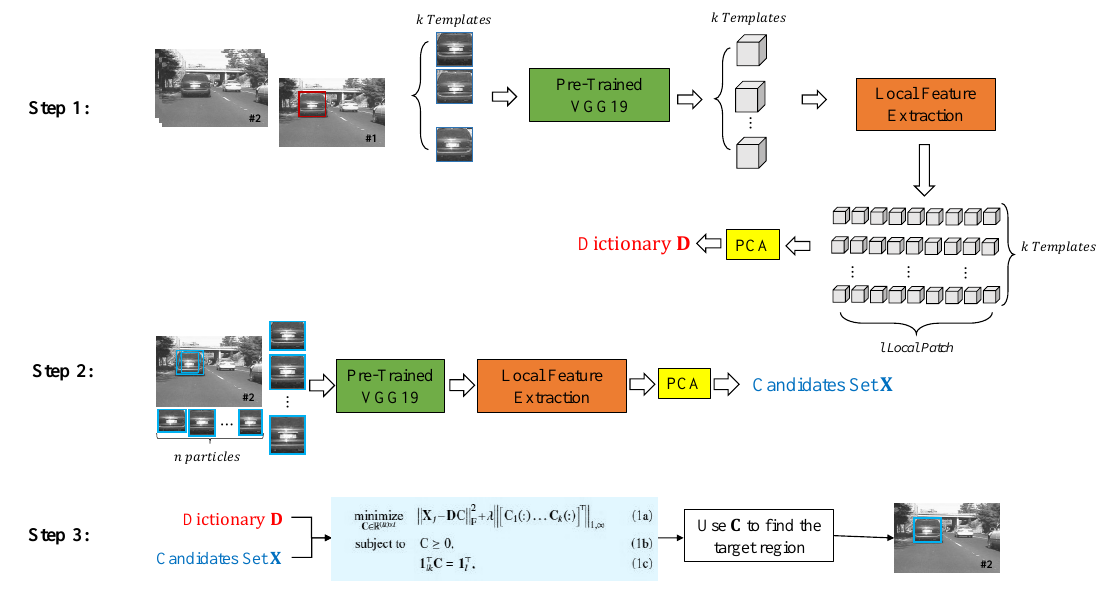
Figure 1. The overview of the proposed STLDF